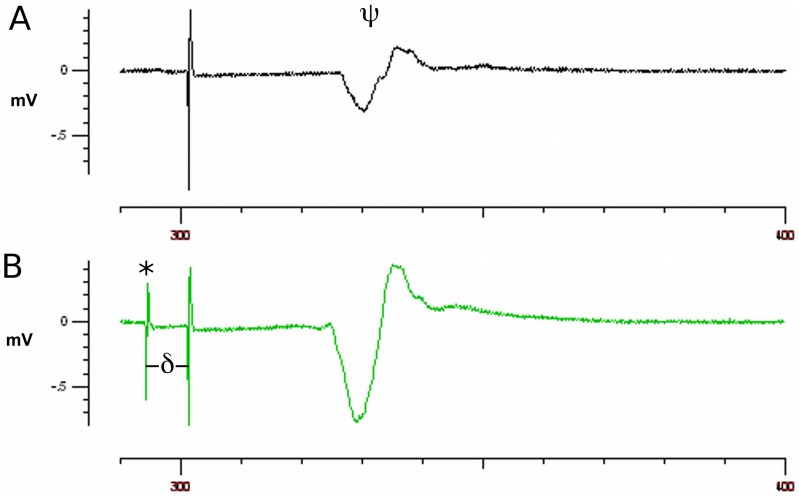
The paired-pulse transcranial magnetic stimulation protocol.(A) Motor evoked potentials (¥) were recorded from the abductor pollicis brevis muscle following magnetic stimulation of the motor cortex. The stimulus intensity required to achieve a target response of 0.2 mV, defined as the resting motor threshold (RMT), was determined following a single magnetic stimulus. (B) Pairs of pulses were then delivered; a conditioning impulse with an intensity set at 70% of RMT (*) followed by a test impulse which varied in intensity in order to maintain the target response of 0.2 mV. As the protocol proceeded, the interval between the two stimuli – defined as the interstimulus interval (∂) – was varied from 1–20 ms. SICI was defined as the increase in test impulse intensity (i.e. test - RMT) required to achieve the target response at interstimulus intervals of 1–7 ms, represented as a percentage of RMT. Please note, this figure (A) is simply intended to illustrate how the RMT is determined and the response reproduced here does not necessarily represent an accurate measurement of RMT. Furthermore, the intensities of the stimuli used in A and B differ; therefore the larger amplitude motor response in B does not necessarily reflect intracortical facilitation following the conditioning impulse.